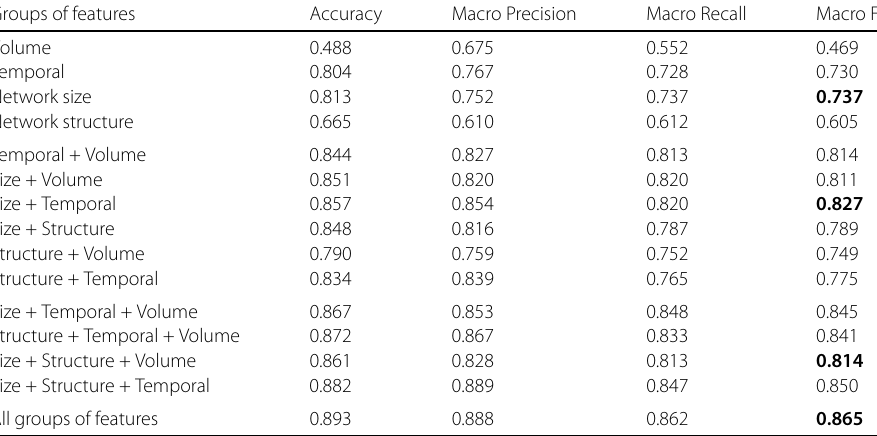
Table 5 Prediction results of the random forest classifier using different combinations of features Groups of features Accuracy Macro